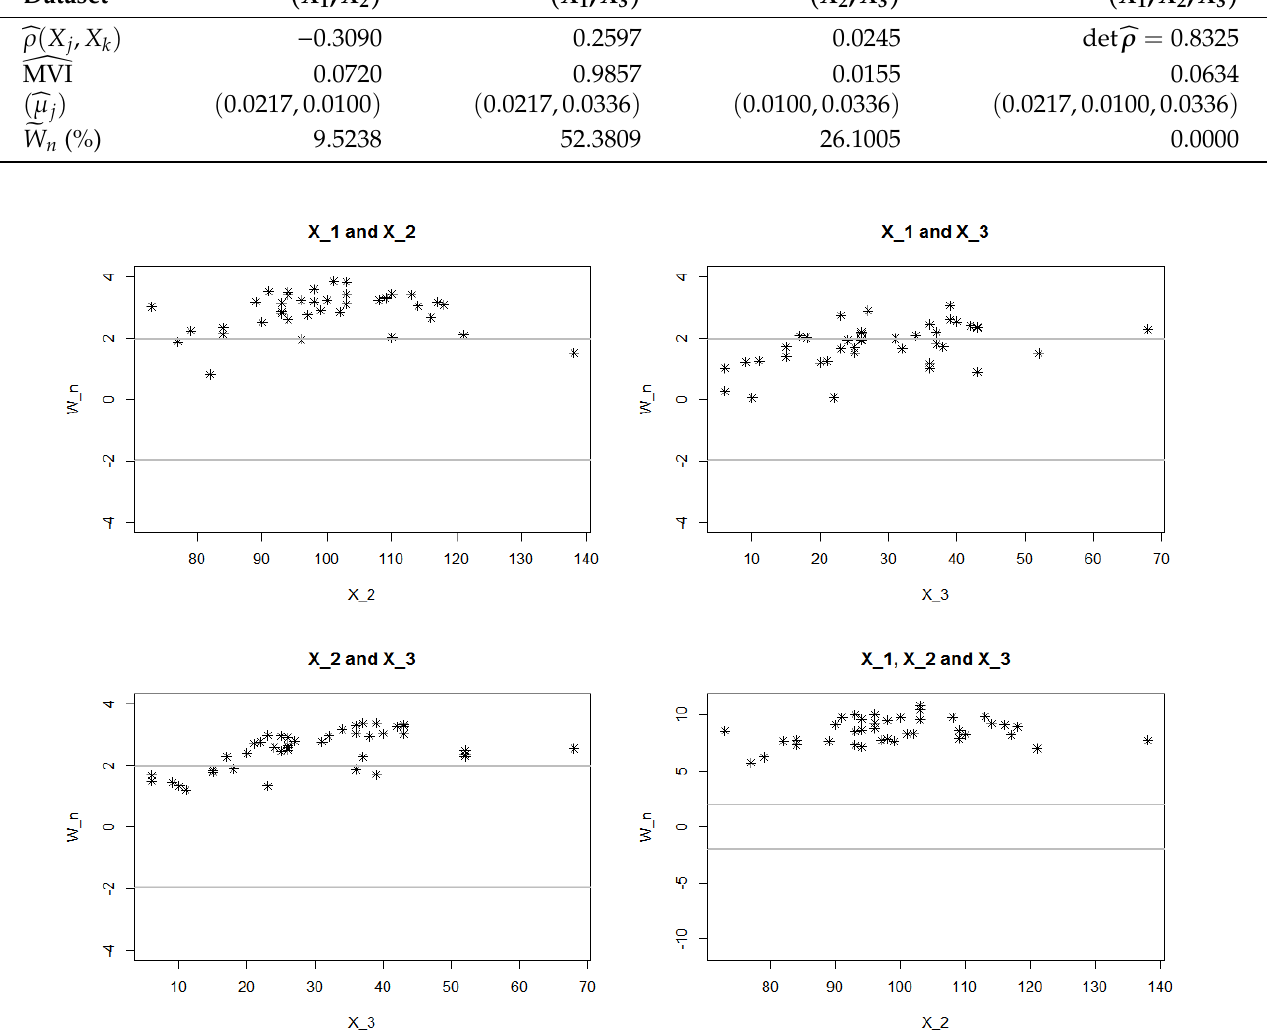
Figure 4. Univariate projections of diagnostic graphs for bivariate and trivariate